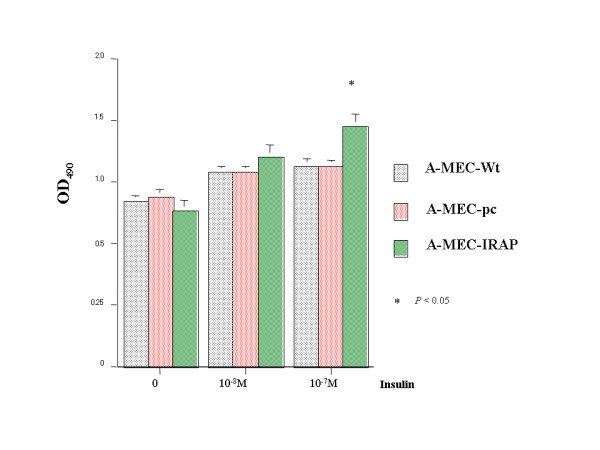
Effect of insulin on cell proliferation in A-MEC, A-MEC-pc, and A-MEC-LAP cells. Treatment with insulin increased cell proliferation at concentrations of 10-8 and 10-7 M. A-MEC-LAP cells exhibited a growth-stimulatory effect via insulin, and the addition of 10-7 M of insulin led to a significant effect compared with A-MEC and A-MEC-pc cells (p < 0.05).